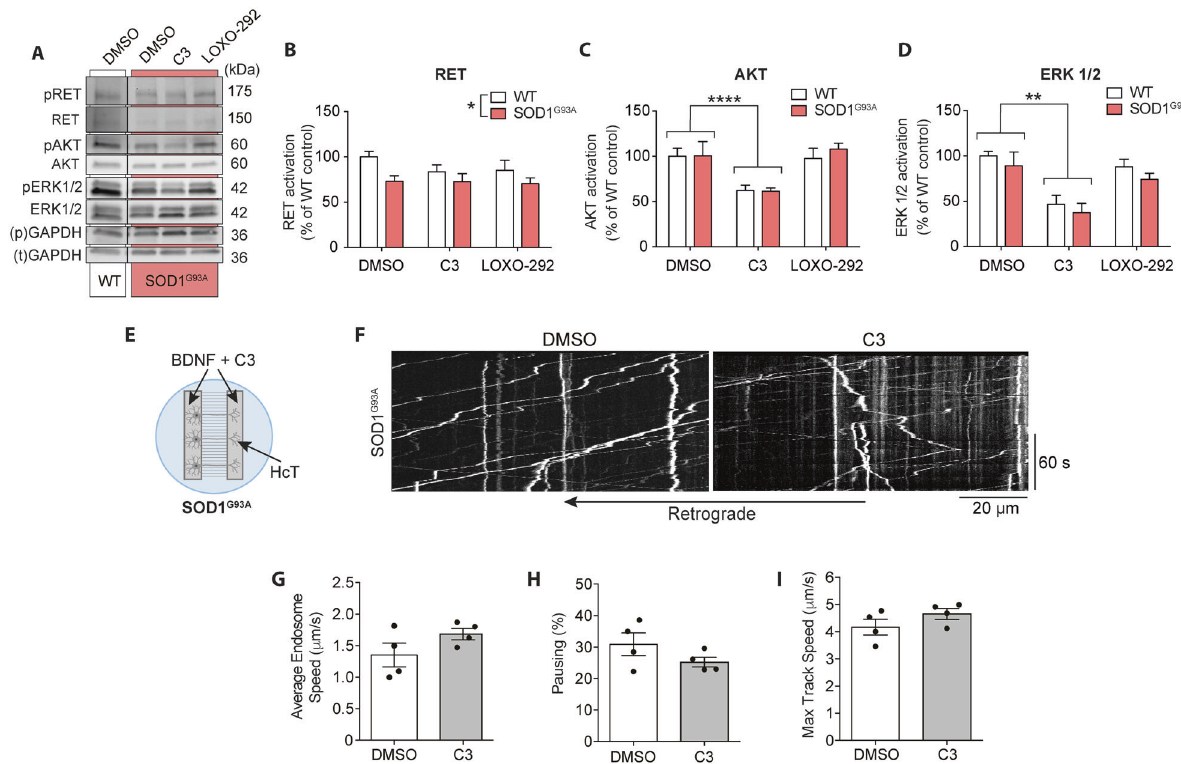
Fig. 5 RET inhibition differentially impacts SOD1 G93A MNs compared to WT. A Representative western blot showing WT and SOD1 G93A primary MN lysates (mass culture) following treatment with DMSO, 1 µM C3 and 100 nM LOXO-292 for 1 h. Full WT blot is shown in Fig. 2G. Samples were run twice on two gels to analyse phosphorylated and total proteins of the same molecular weight. Bands were normalised to corresponding GAPDH loading control (phospho- “ p ” , total “ t ” ). B Quanti fi cation of RET activation from western blots of WT and SOD1 G93A primary MN lysates (1 µM C3, 100 nM LOXO-292; see also Fig. 2). There was no signi fi cant difference in RET activation comparing DMSO to either RET inhibitor (two-way ANOVA p = 0.1629); however, SOD1 G93A cultures have reduced RET activation compared to WT (two-way ANOVA; * p = 0.0181). C Quanti fi cation of AKT activation. C3 signi fi cantly inhibits AKT activation compared to DMSO (two-way ANOVA with Tukey ’ s multiple comparison test; **** p < 0.0001), but LOXO-292 has no signi fi cant effect. D Quanti fi cation of ERK1/2 activation. C3 signi fi